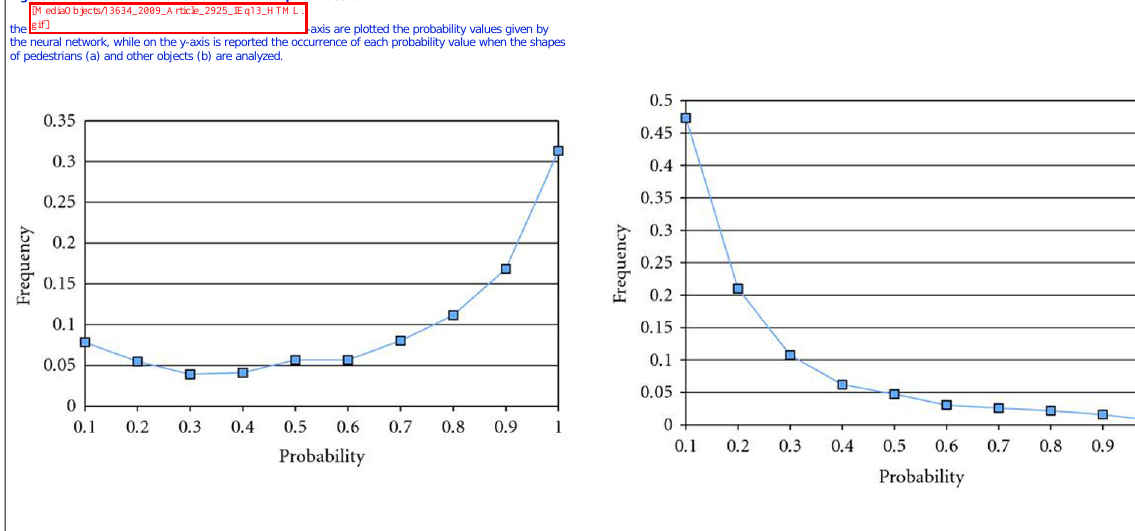
Figure 6 Distribution of the neural network output values. On